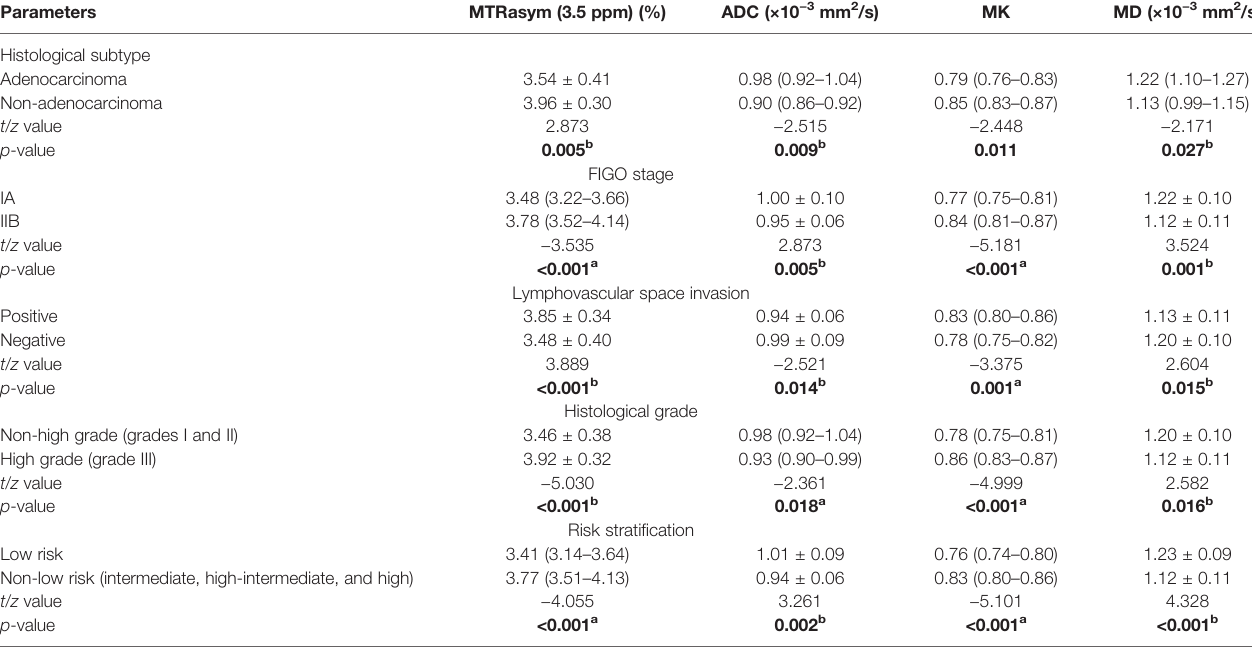
TABLE 3 | Comparison of the different parameters among different groups. Parameters